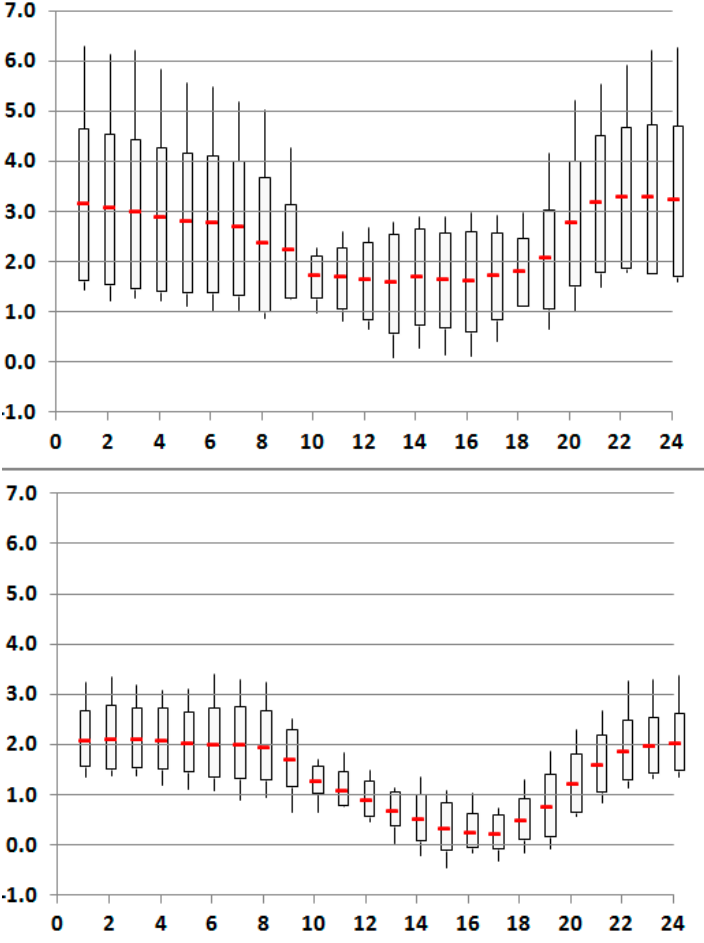
Figure 8. Box plots of hourly UHI intensity during 2016 for Presidente Prudente ( top ) and Rennes ( bottom ). X axis legend = hours (local time). Y axis legend = difference between downtown and rural in °C.